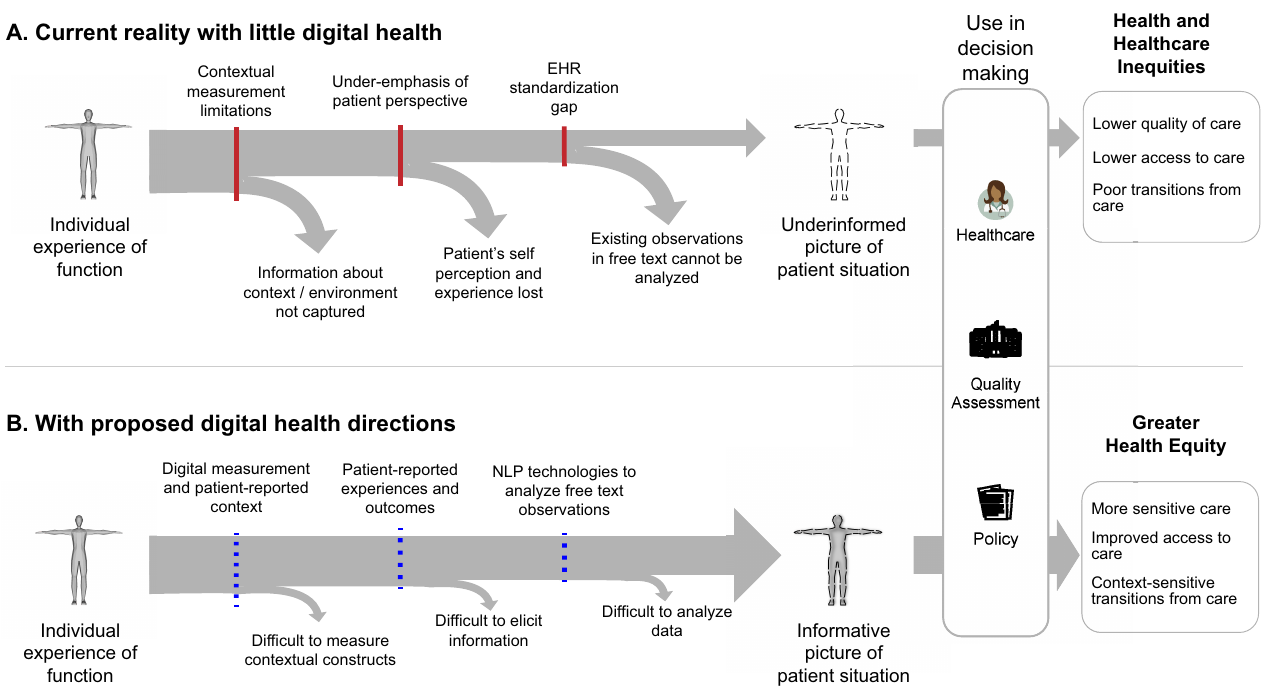
Fig 1. Information barriers to a complete picture of patients’ unique situations in EHR create information inequities at multiple levels. AU : AbbreviationlistshavebeencompiledforthoseusedinFigs 1 ; 2 ; and 4 to 6 : Pleaseverifythatallentriesarecorrect : Panel (A): We describe 3 significant information barriers in current practice, which significantly reduce the amount of information about patients’ situations recorded in the EHR and negatively impact decisions made about patient care based on the EHR. Panel (B): We identify 3 directions for new research on digital health technologies to facilitate better understanding patient experience. EHR, electronic health record.